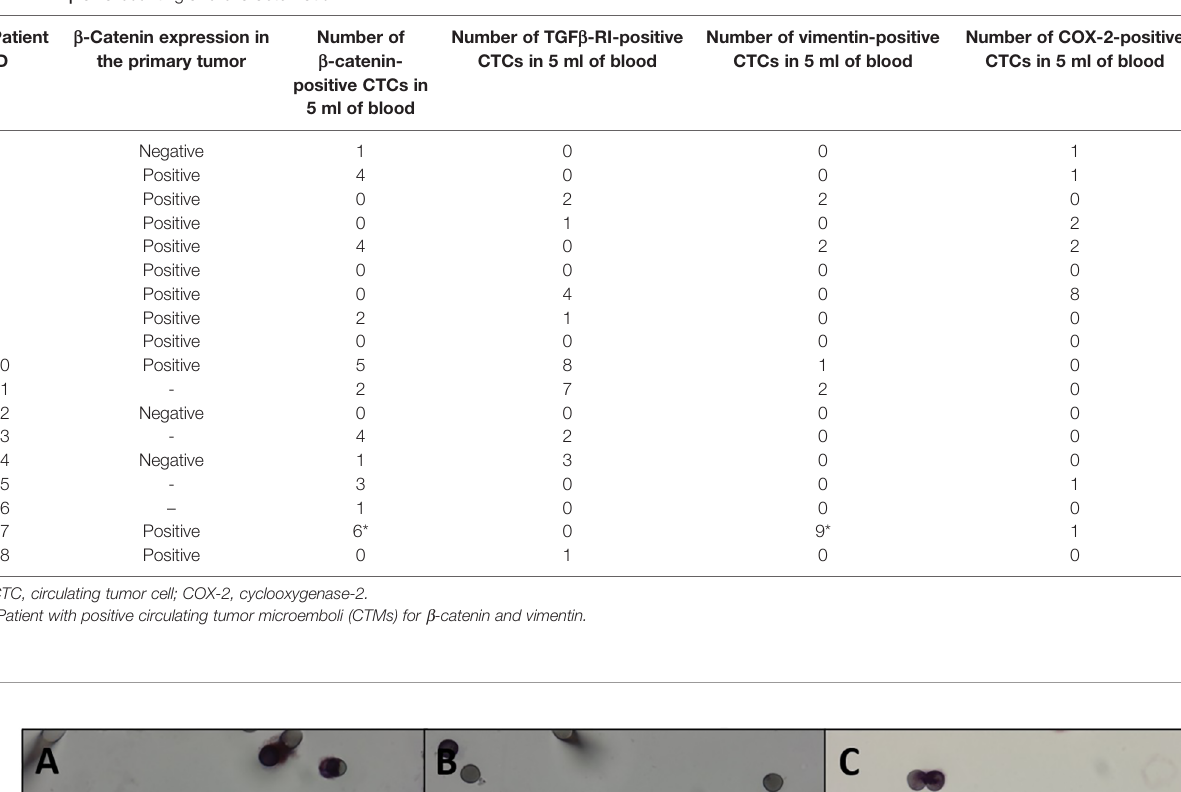
TABLE 2 | CTC counting and characterization.